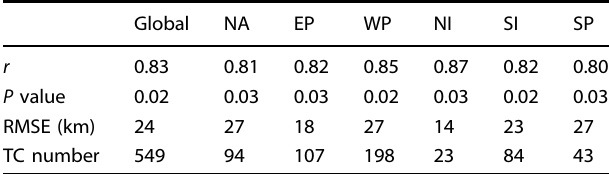
The Pearson correlation coef fi cient r , P value and root-mean-square error (RMSE) are the mean of all fi ttings in each basin and globally. The P value is two-sided with a null hypothesis that the slope is zero using Wald test with